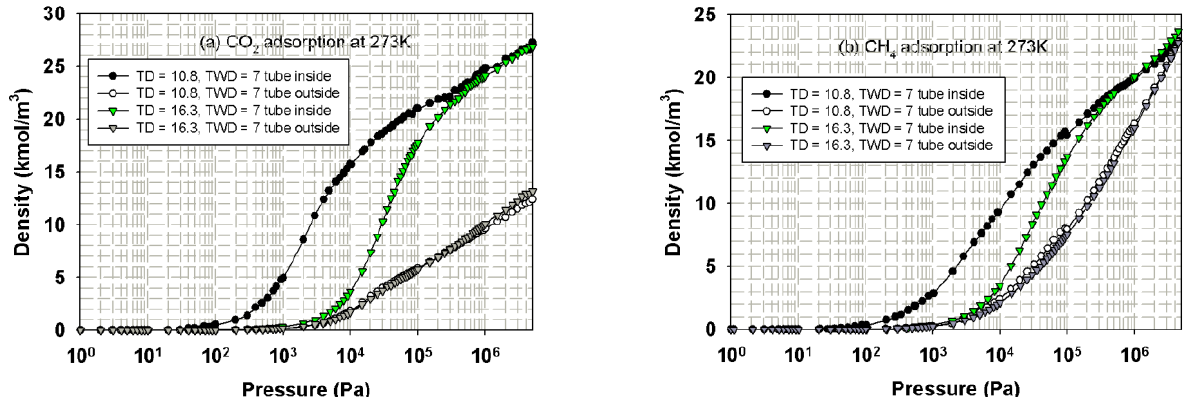
Figure 13. Isotherms of CO 2 ( a ) and CH 4 ( b ) in bundles of tube size 10.8 and 16.3 Ǻ at 273 K.